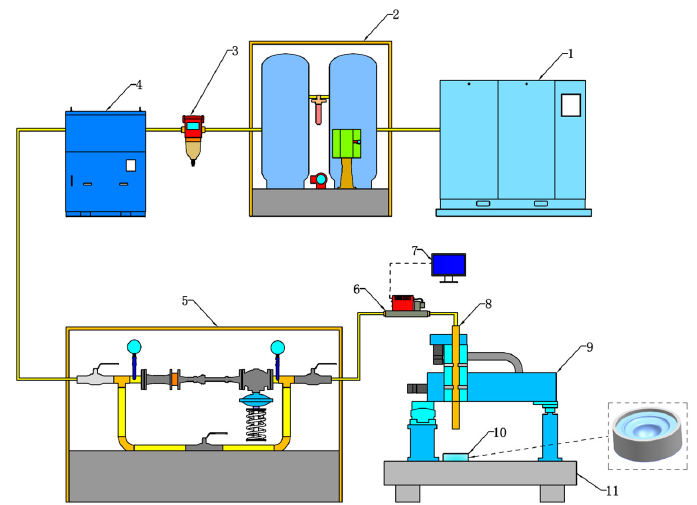
Figure 5. The experiment device. (1) air compressor (2) combined gas tanks (3) water–oil separator (4) refrigeration dryer (5) Gas MFC (6) gas jet controller (7) upper computer (8) precision electroplated nozzle (9) precision three-axis moving platform (10) glass mould (11) marble platform.